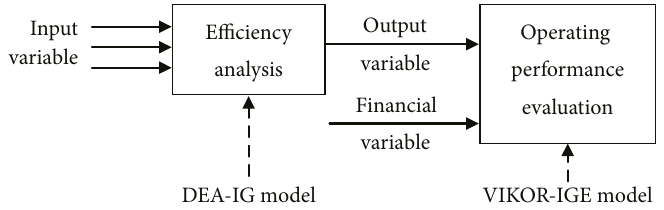
Fig. 1. A conceptual framework of the decision-making